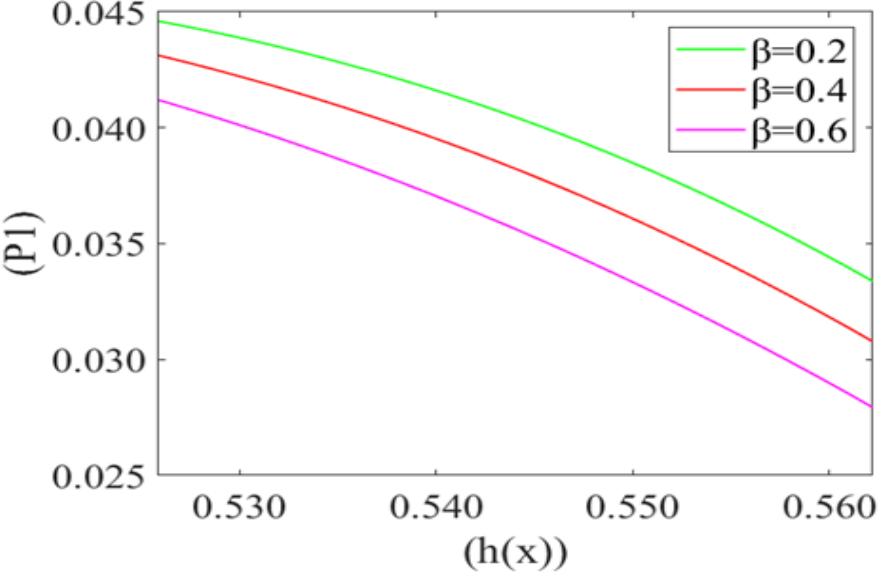
Figure 6. Variation of mean pressure gradient ( P1 ) with the height of the lubricating film h(x) of plasma between the cell and capillary wall for different compliance ( β ) with Re = 0.025, P2 = 5, k = 0.1. Leak back in microcirculation promotes the flow in the capillary. The above Figures 7–9 shows the relationship between leak back ( Q ) and the height of lubricating film h(x) for different values of mean pressure gradient (i.e., P1 = 0.7, 0.8, 0.9), local pressure ( P2 = 0.5, 0.6, 0.7) and cell compliance ( β = 0.10, 0.15, 0.20), respectively. Figure 7 shows that the leak back Q increases linearly with increase in the width of lubricating film h(x) . Leak back Q attains Maximum value for P1 = 0.7 and minimum value for P1 = 0.9. It shows that leak back decreases with an increase in mean pressure gradient value.